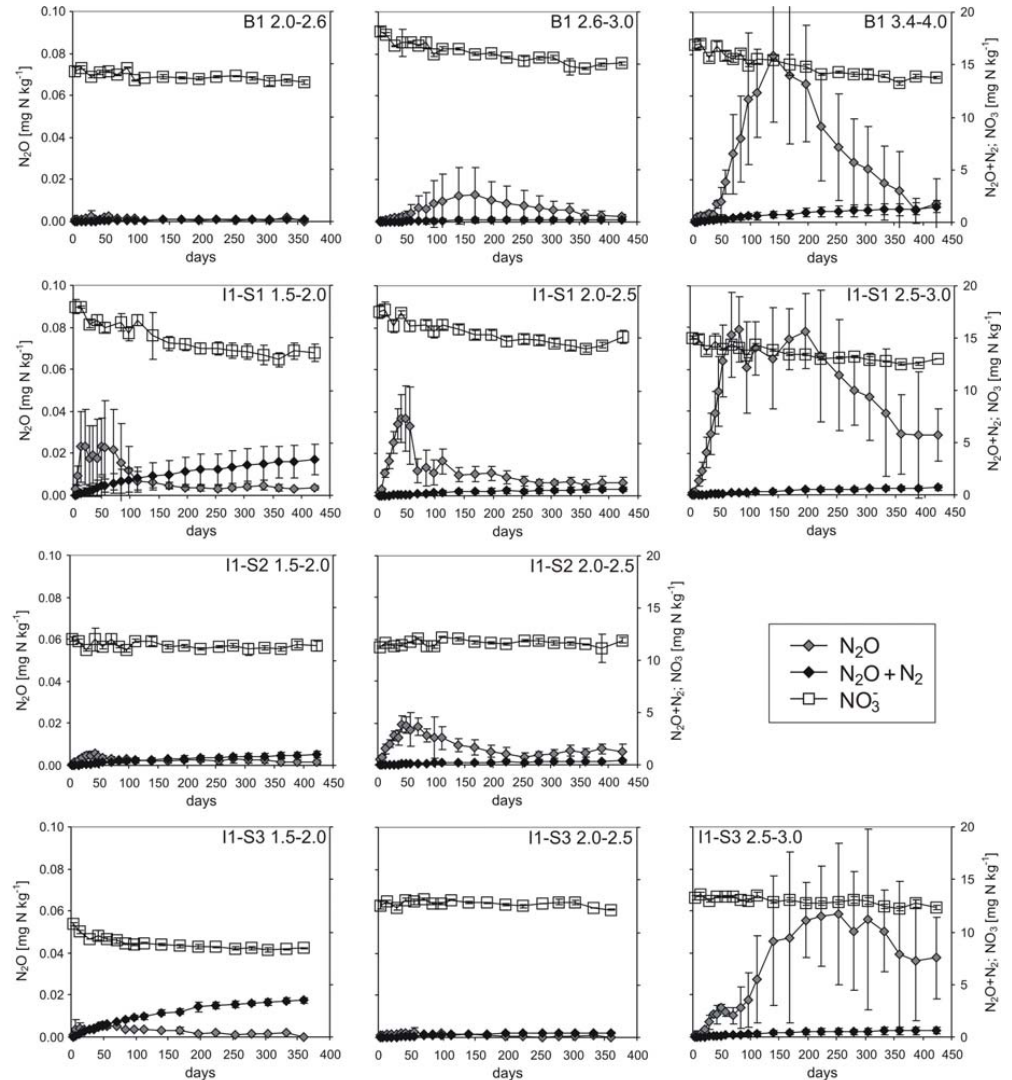
Fig. 2. Concentration courses of N 2 O, N 2 O+N 2 , and NO − during long-term anaerobic incubation of aquifer material from the heterotrophic 3 denitrification zone. The symbols denote the means of 4 replications and the error bars represent the standard